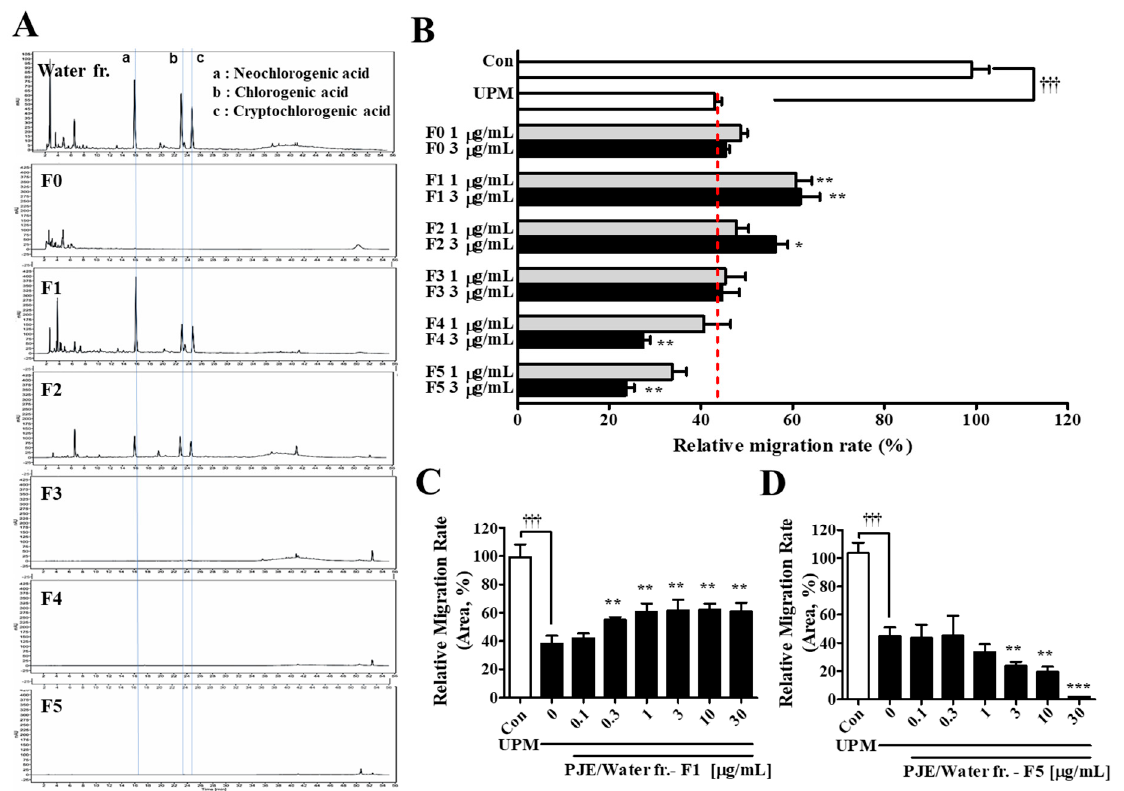
Figure 10. HP-20 open column chromatography of the water fraction of PJE (PJE/W) and the effects of these fractions on HCEC wound healing. ( A ) HPLC chromatograms of PJE and its fractions (F0~F5). ( B ) The migration rates of each fraction were calculated, and data from the concentrations of 1 μ g/mL and 3 μ g/mL are presented as the means ± SD. ( C ) The migration rates of ( C ) F1 and ( D ) F5 are presented as the means ± SD. ††† p < 0.001 compared to Con; * p < 0.05, ** p < 0.01 *** p < 0.001 compared to 0 μ g/mL PJE.